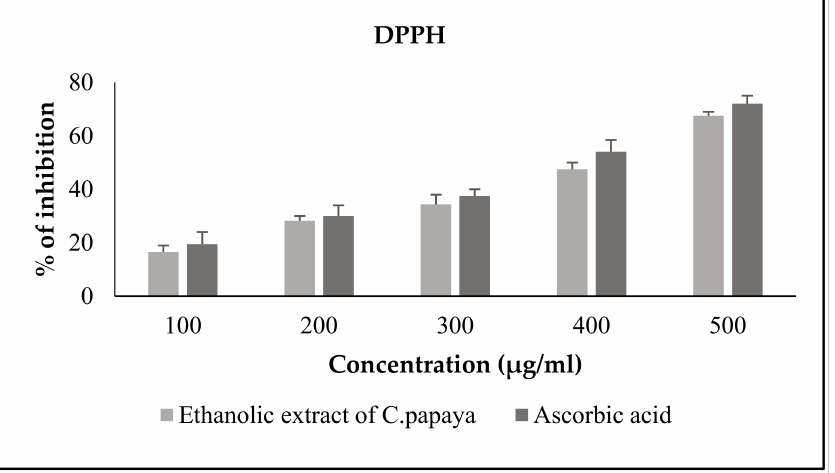
Figure 1. Effect of C. papaya ethanolic extract on DPPH radical scavenging activity. Each bar represents the mean ± SEM of five observations.